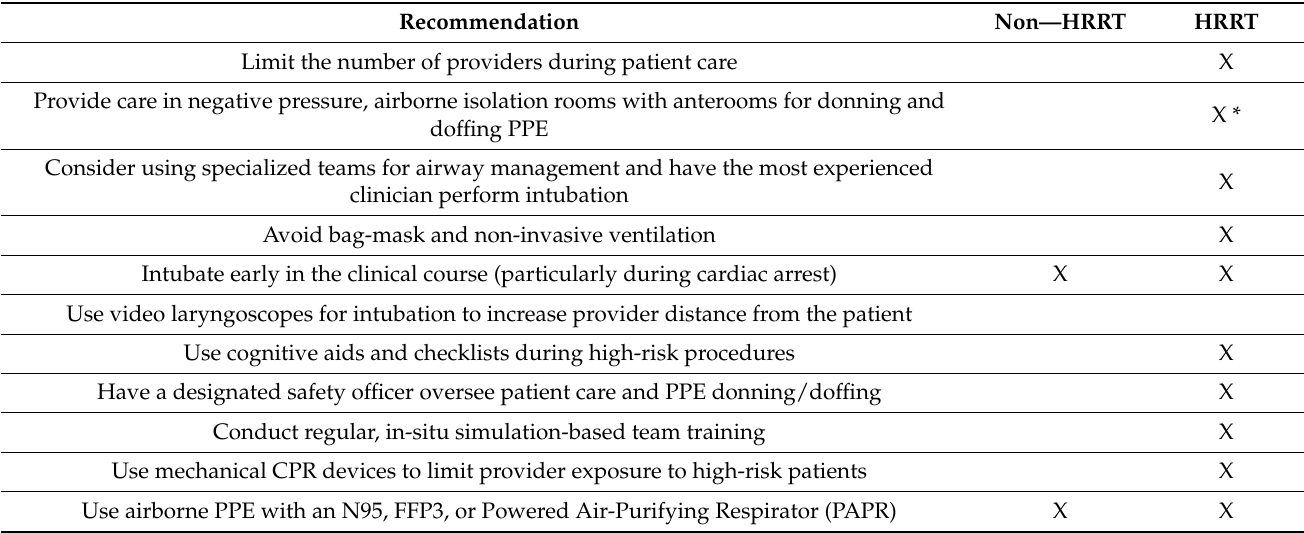
Table 1. Recommendations for airway management in patients suspected or confirmed to have COVID-19 distilled from non-systematic narrative literature review. Categorized into feasibility for regular-duty paramedics (Non-HRRT) vs. HRRT within system constraints at the start of the pandemic. * HRRT crews adapted this recommendation by designating ‘hot’ and ‘warm’ zones with controlled access and